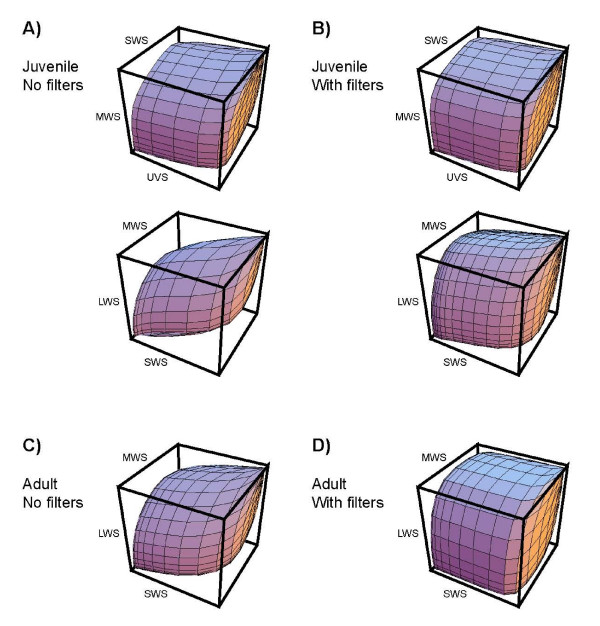
Object colour solids of juvenile and adult lungfish. The volume of the object colour solid was calculated for juvenile (A, B) and adult (C, D) lungfish, both with (A, C) and without (B, D) the filtering effects of the yellow ellipsoidal and red oil droplet spectral filters in the MWS and LWS cones. The tetrachromatic colour space of the juvenile lungfish (A, B) is shown by two different projections of the spaces defined by the quantum catches of the UVS, SWS and MWS cones and also the SWS, MWS and LWS cones. Note the increase in the volume of the object-colour solid (and consequently the number of discriminable colours) in both juveniles (B) and adults (D) with spectral filters, relative to the situation without the effects of spectral filters. See Fig. 2 for explanation of abbreviations. Projections were generated using Mathematica software (Wolfram Research, Inc., Champaign, IL, USA).